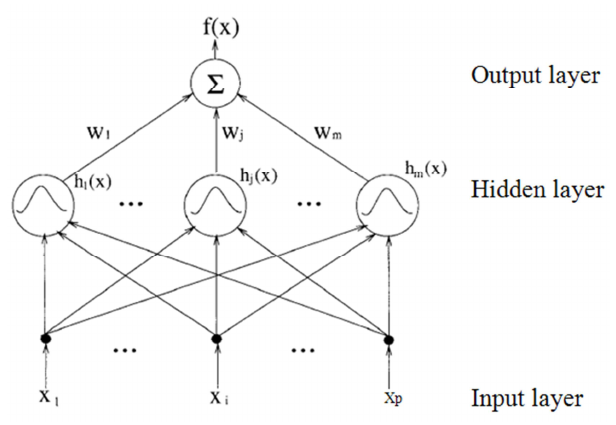
F IG . 1: The general structure of RBF network. Fig. 1. The general structure of RBF